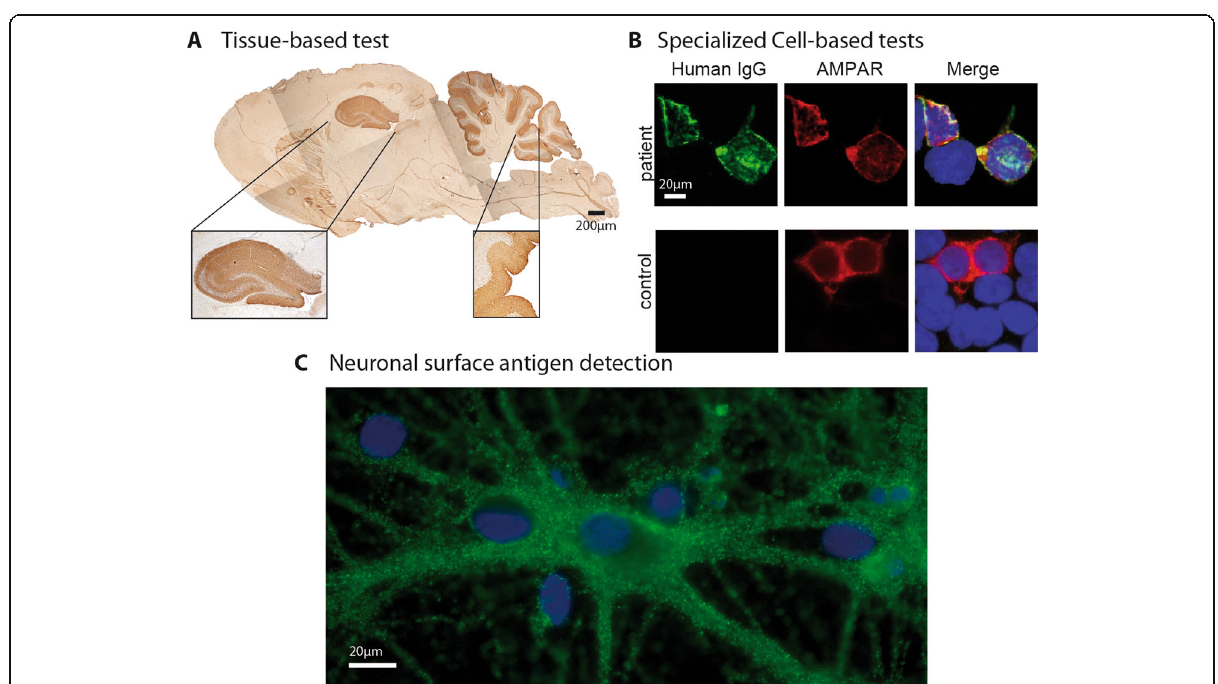
Fig. 1 Example of comprehensive aurtoantibody testing available in scientiifc research settings. a Tissue-based test using sagittal rat brain sections optimized for detection of neuronal surface antibodies. Brown staining indicates specific binding of human IgG. Hippocampal and cerebellar regions are shown magnified. Shown is an example of the staining obtaining with GABA(A) receptor antibody containing patient CSF. b Cell-based assay with HEK293 cells expressing human autoantigens. This example shows cells transfected with AMPA receptor subunits stained with serum of a patient with anti-AMPA receptor encephalitis. Green staining indicates human IgG, red staining indicates a commercial antibody detecting transfected cells. Merged images are shown on the right side. Yellow indicates cells transfected and detected by human IgG thus indicating presence of autoantibodies targeting the transfected antigen. In addition to the shown example of cells fixed with paraformaldehyde, for some autoantibodies non-fixed live-cell based assays, which stain cells before addition of fixatives are more sensitive for the detection of some autoantibodies (e.g. MOG, not shown). c Primary, embryonal, rat hippocampal neurons are stained with serum from a patient with anti- AMPA receptor encephalitis. Cells are alive and non-permeabilized so that only surface antigens are detected by autoantibodies. Green indicates human IgG binding to individual synapses, blue is a DAPI counterstaining of nuclei to demonstrate presence of